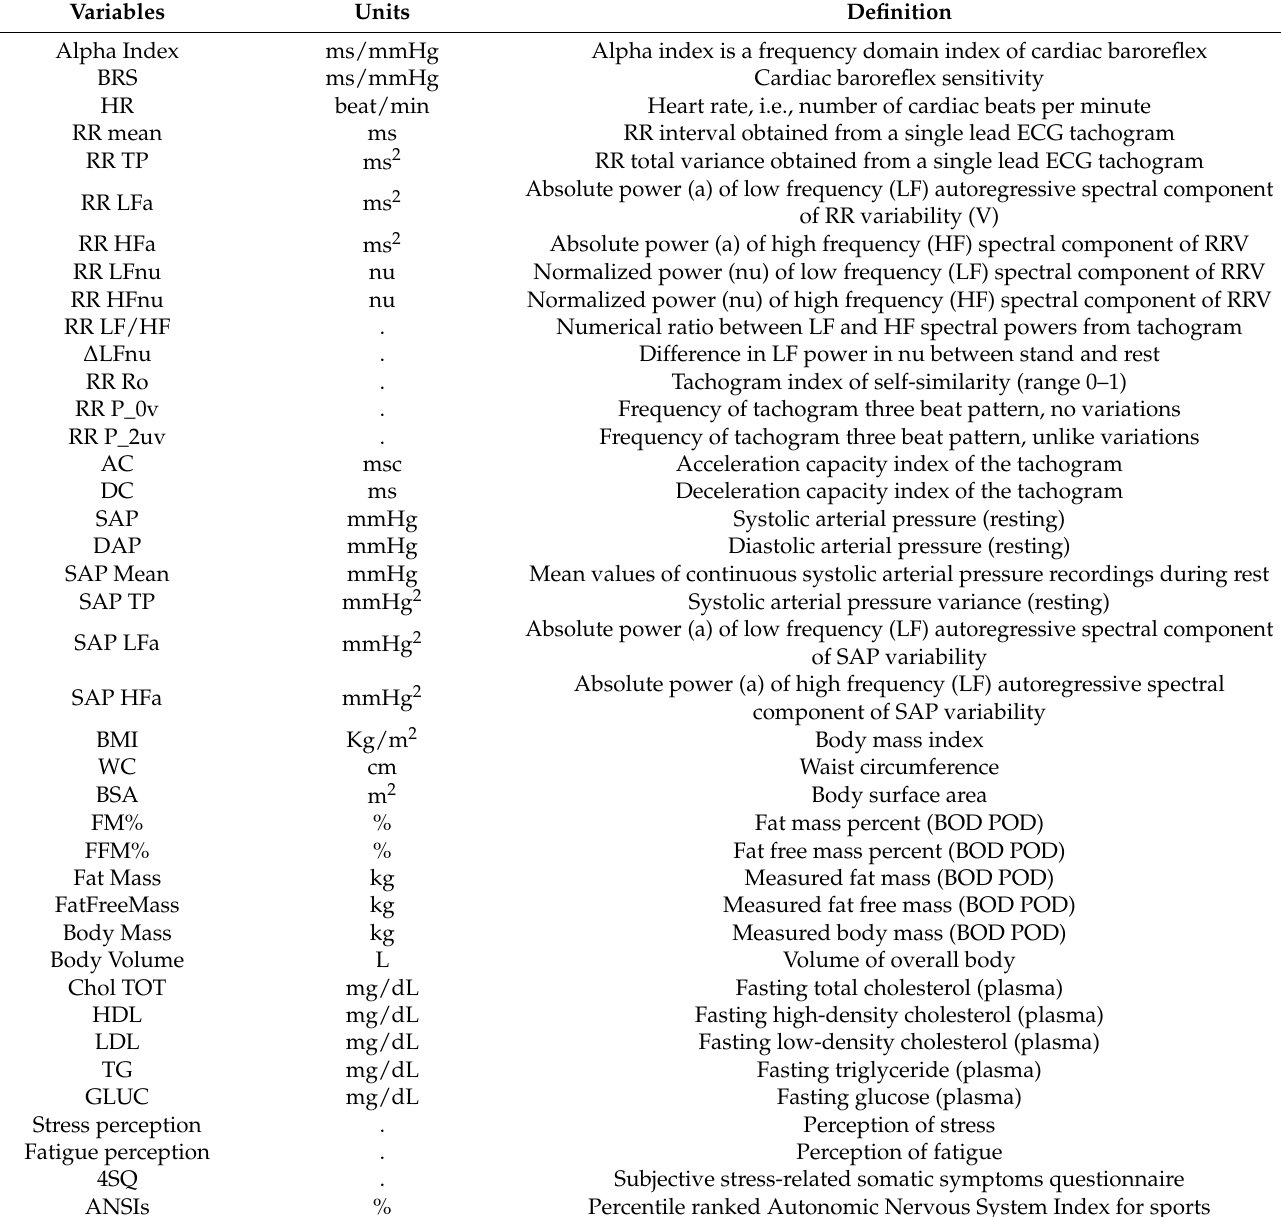
Table 1. List of the abbreviations and definitions of variables employed in the